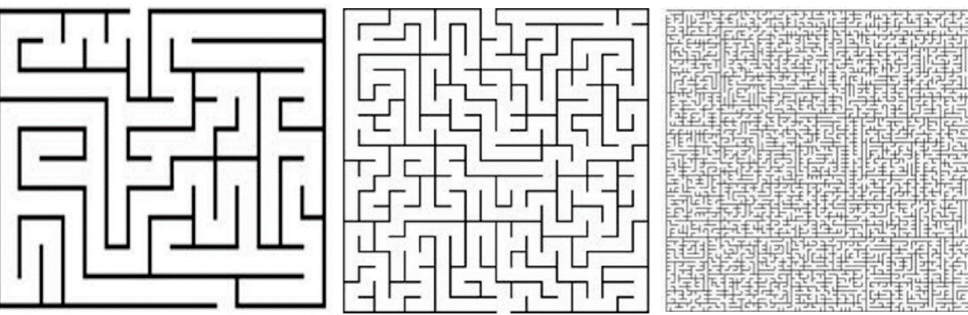
Figure 5. Cognitive Bias in the Exercise of Problem Solving (authors).